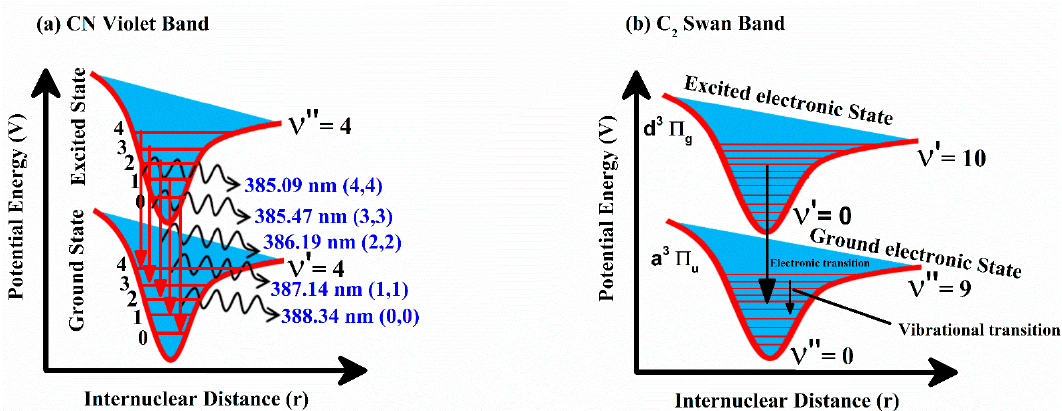
Figure 2. ( a ) Schematic diagram for the spectra of nylon in the CN spectral region ( b ) Potential energy against internuclear distance curves for the two electronic states of the C 2 Swan band system, revealing the various